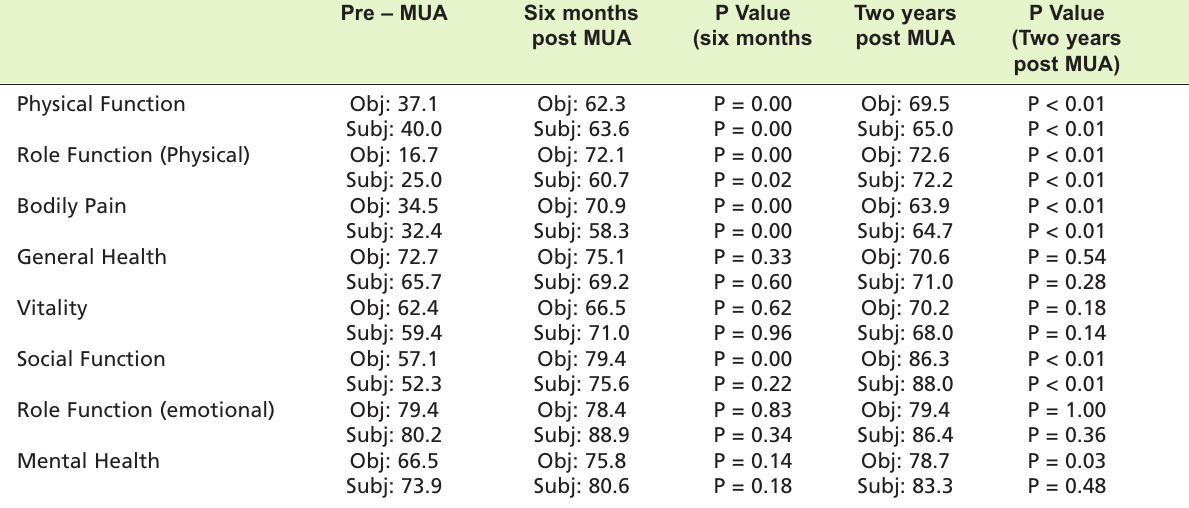
SF36 Component Score Comparison Pre-MUA and six months, two years Post MUA. Table IV: Pre –